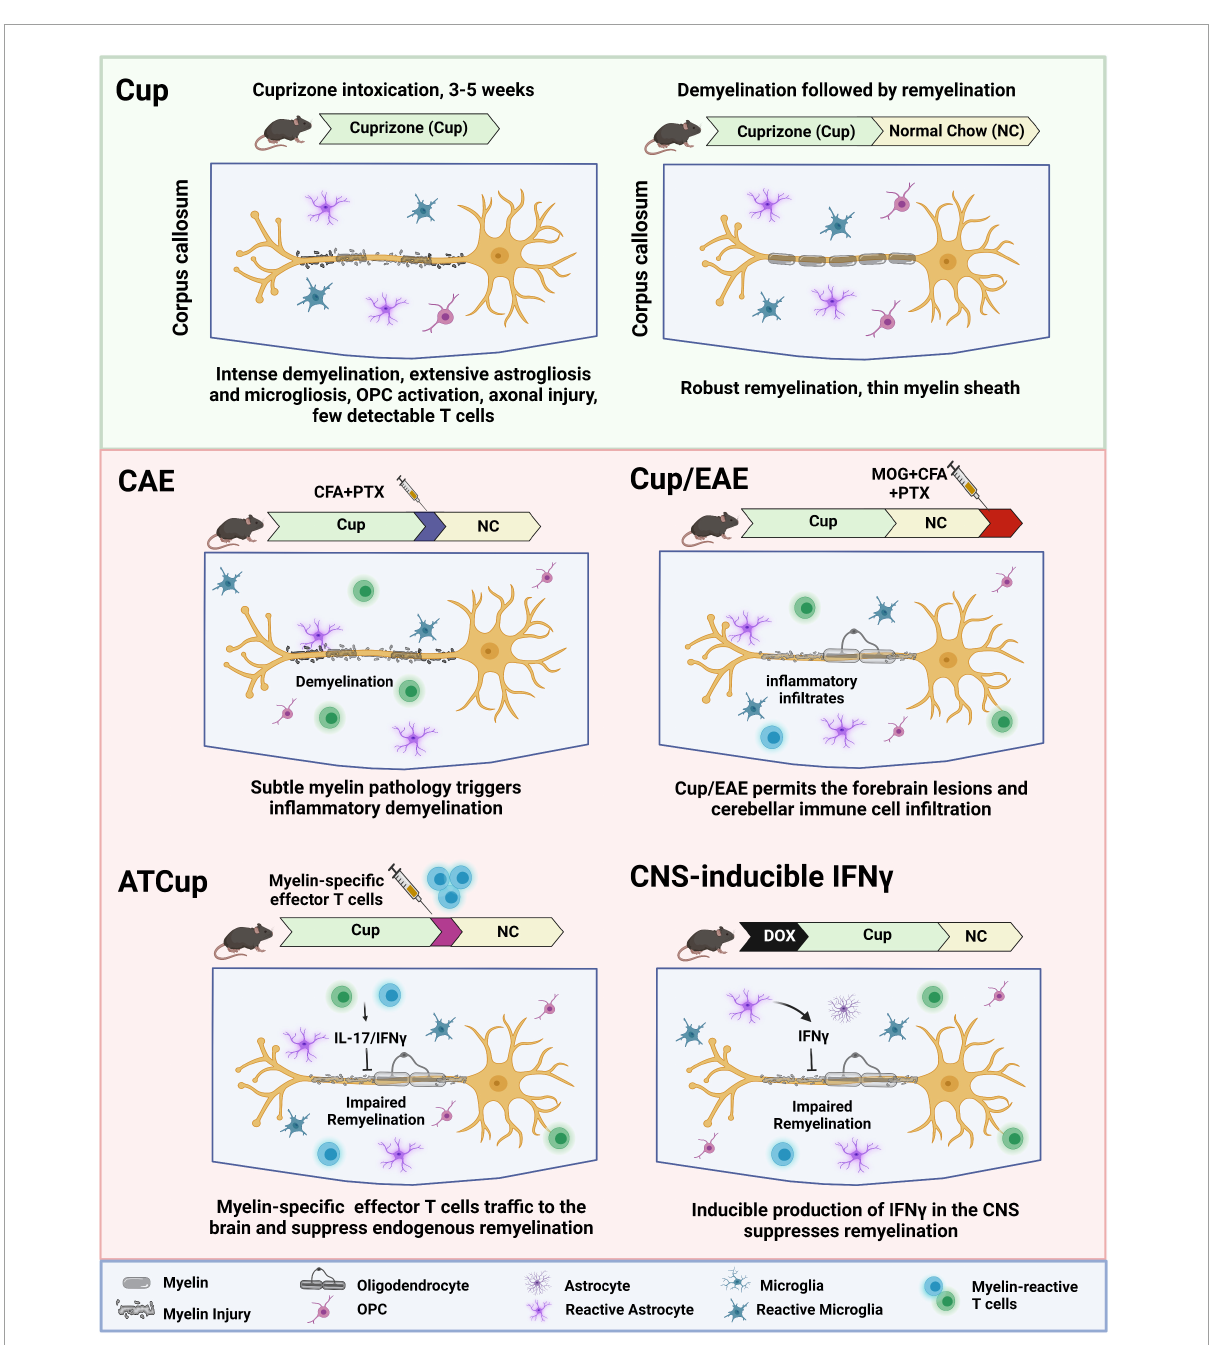
FIGURE1 Schematic overview of inflammatory demyelination models, showing how inflammation contributes to de- and re-myelination following cuprizone intoxication. ATCup, Adoptive Transfer Cuprizone; CAE, Cuprizone Autoimmune Encephalitis; CFA, Complete Freund’s Adjuvant; DOX, Doxycyclin; EAE, Experimental Autoimmune Encephalomyelitis; MOG, Myelin oligodendrocyte glycoprotein; OPC, Oligodendrocyte precursor cells; PTX, Pertussis